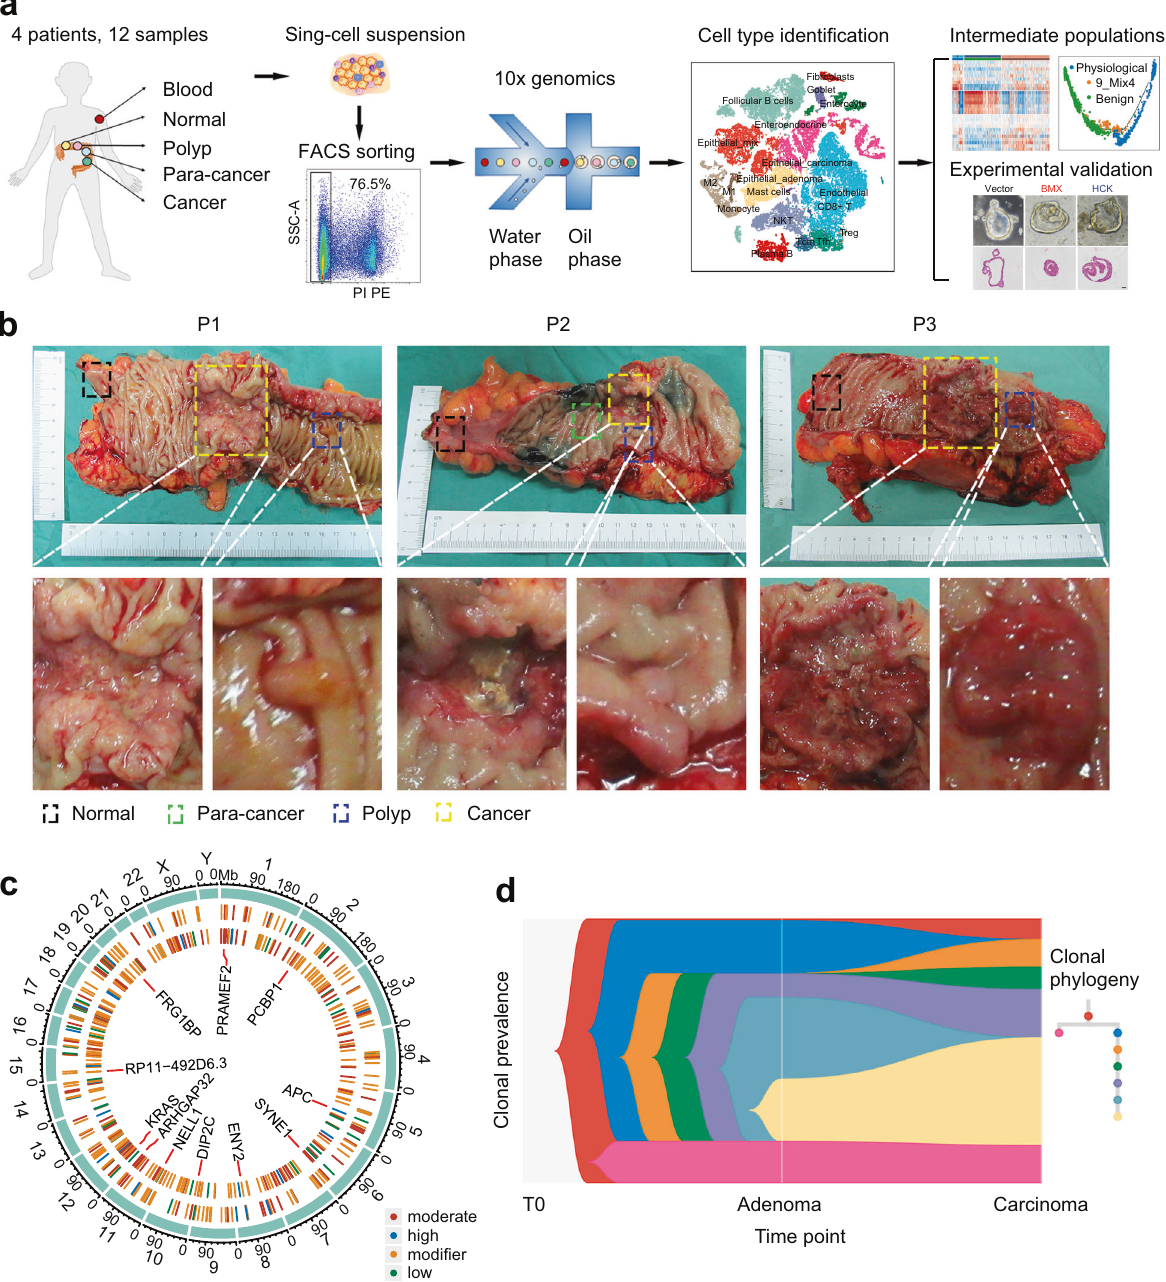
Fig. 1 Sample collection and quality control. a Flowchart of library preparation and data analysis. b Samples were collected from surgically resected specimens of patients with colorectal polyp and cancer. Patients were numbered as patient 1 (P1), patient 2 (P2), and patient 3 (P3). c Circos graph shows single nucleotide variants in adenoma and carcinoma (exempli fi ed by P3). The inner and intermediate cycles represent carcinoma and adenoma, respectively. Colors represent variant impact. The same single nucleotide variants of adenoma and carcinoma are shown in the center of the cycle. d Clonal evolution of adenoma and carcinoma (exempli fi ed by genes, including enterocytes ( GUCA2A , SLC26A3 , and CA1 ), goblet dimensional analysis (Fig. 3a and Supplementary Fig. 6a). Owing to cells ( MUC2 and TFF3 ), enteroendocrine cells ( CHGA ), and stem the insuf fi cient number of epithelial cells, we excluded patient 3 cells ( LGR5 ). The results of cell counting indicated that physiolo- from this analysis (Supplementary Fig. 3g). Cells from normal, gical, benign, and malignant cells were predominantly from adenoma, and carcinoma tissues were clearly separated from each normal, adenoma, and carcinoma tissues, respectively (Fig. 3d and other (Fig. 3b and Supplementary Fig. 6b). We then categorized Supplementary Fig. 6d). Representative DEGs were divided into epithelial cells into physiological, benign, malignant, and other three groups (1, 2, and 3) that were consistent with canonical populations based on their pathological genetic markers 31 (Fig. 3c markers, corresponding to physiological, benign, and malignant and Supplementary Fig. 6c). Several intestinal cell subtypes were stages (Fig. 3e). Sequential upregulation of these DEGs during CRC identi fi ed based on the canonical colorectal epithelial marker